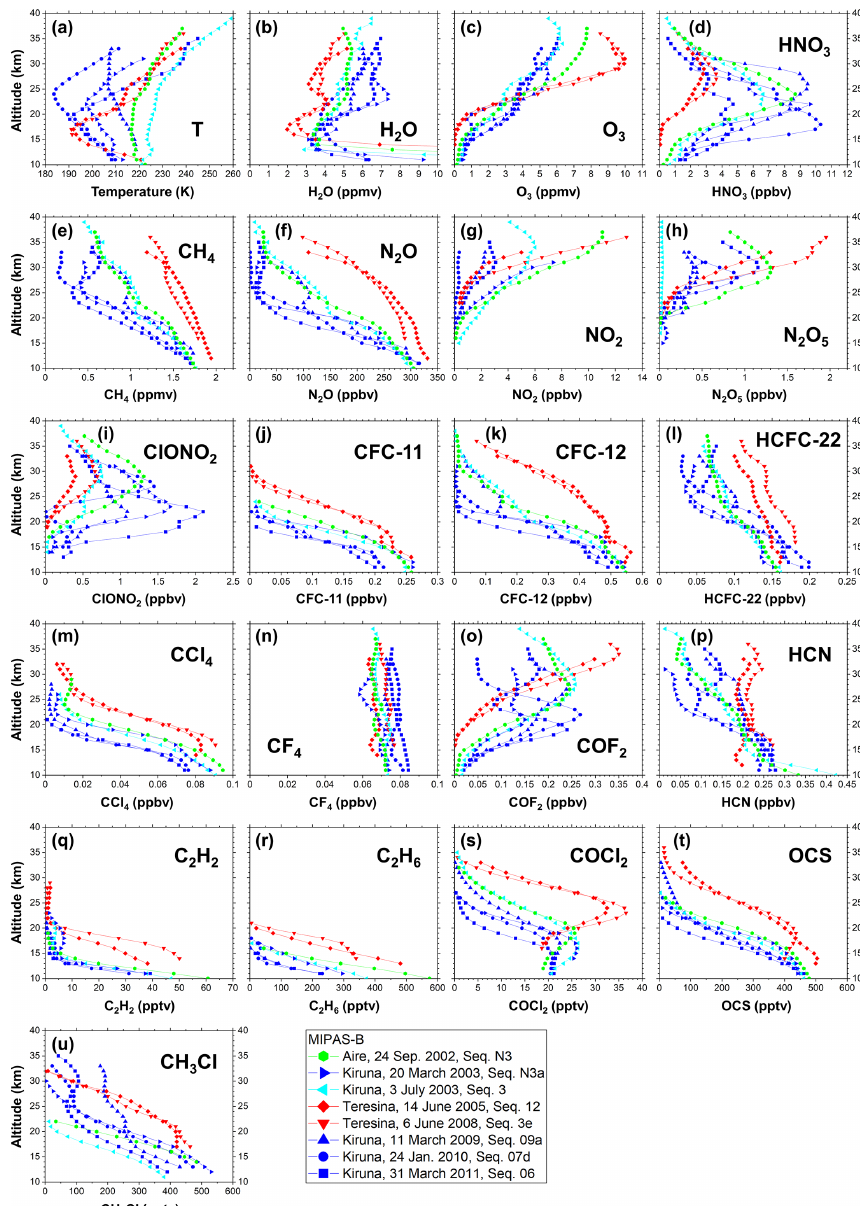
Figure 1. Retrieved vertical profiles of temperature (a) and species (b–u) of Arctic winter (blue), Arctic summer (cyan), midlatitude (green), and tropical (red) MIPAS-B flights, as listed in Table